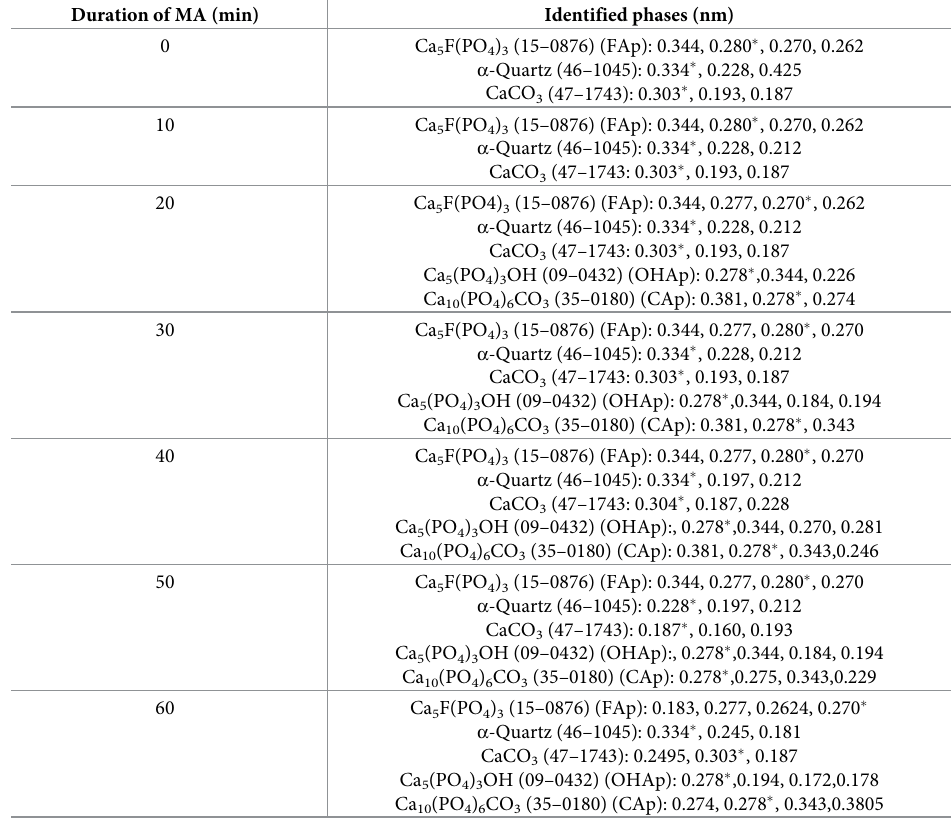
Table 2. The d-spacing values and XRD phase analyses of the major and minor phases of phosphorite.